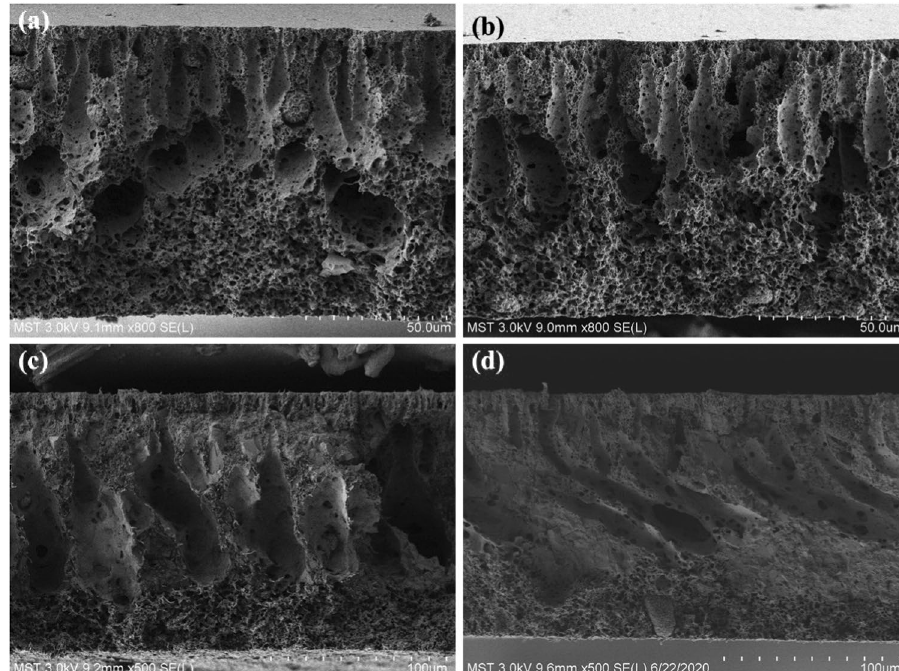
Fig. 3 Cross-section images of after alkali